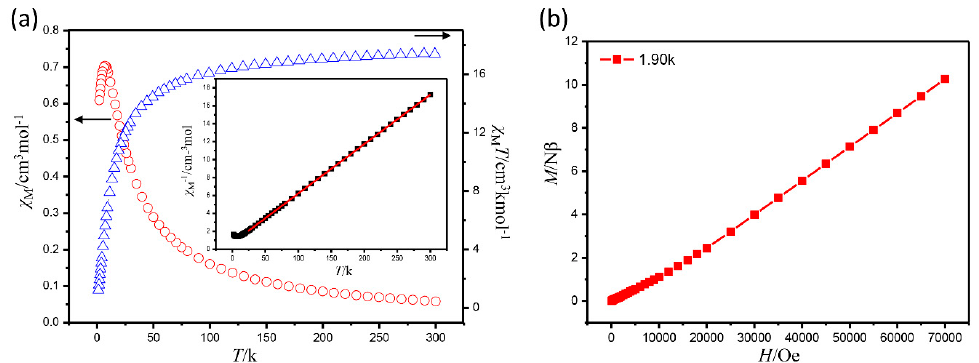
Figure 5. ( a ) Temperature dependence of χ M T ( Δ ), χ M ( ○ ), and χ M − 1 ( □ , inset) for compound 2 with an applied fi eld of 1000 Oe. The solid line corresponds to the theoretical fi t of the Curie − Weiss law χ M = C/(T − θ ) . ( b ) Field dependence of magnetization for 2 at 2 K.